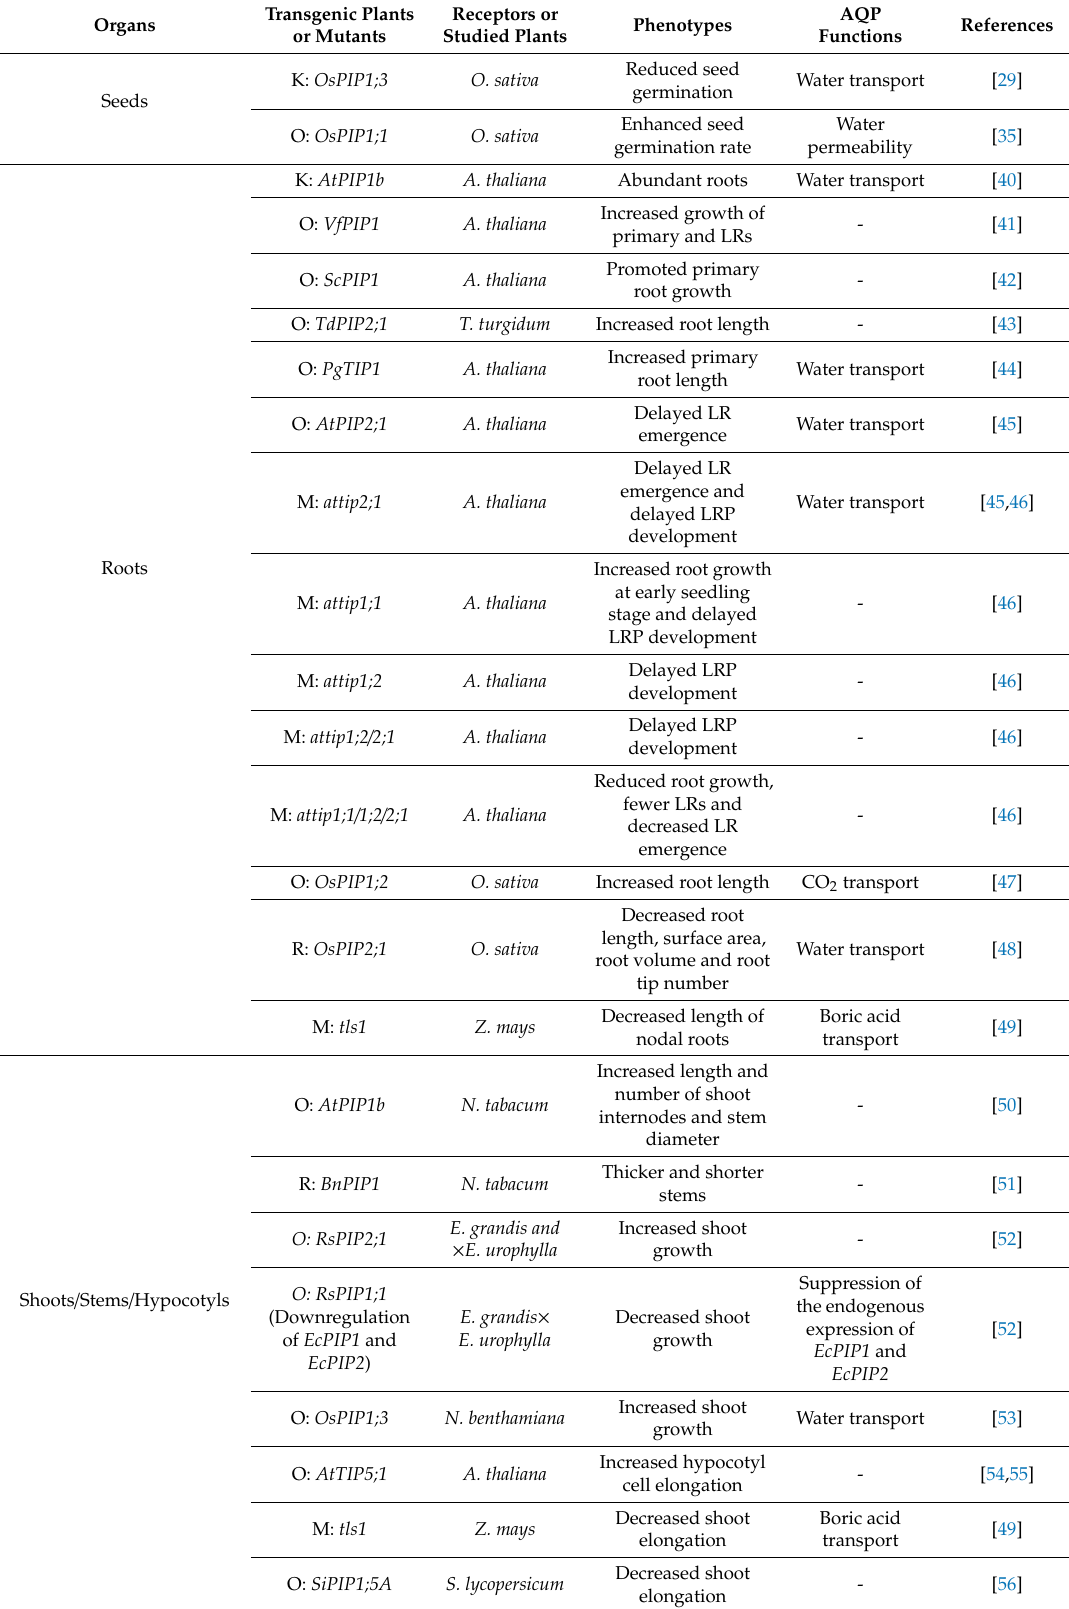
Table 1. The roles of AQPs in the growth of vegetative